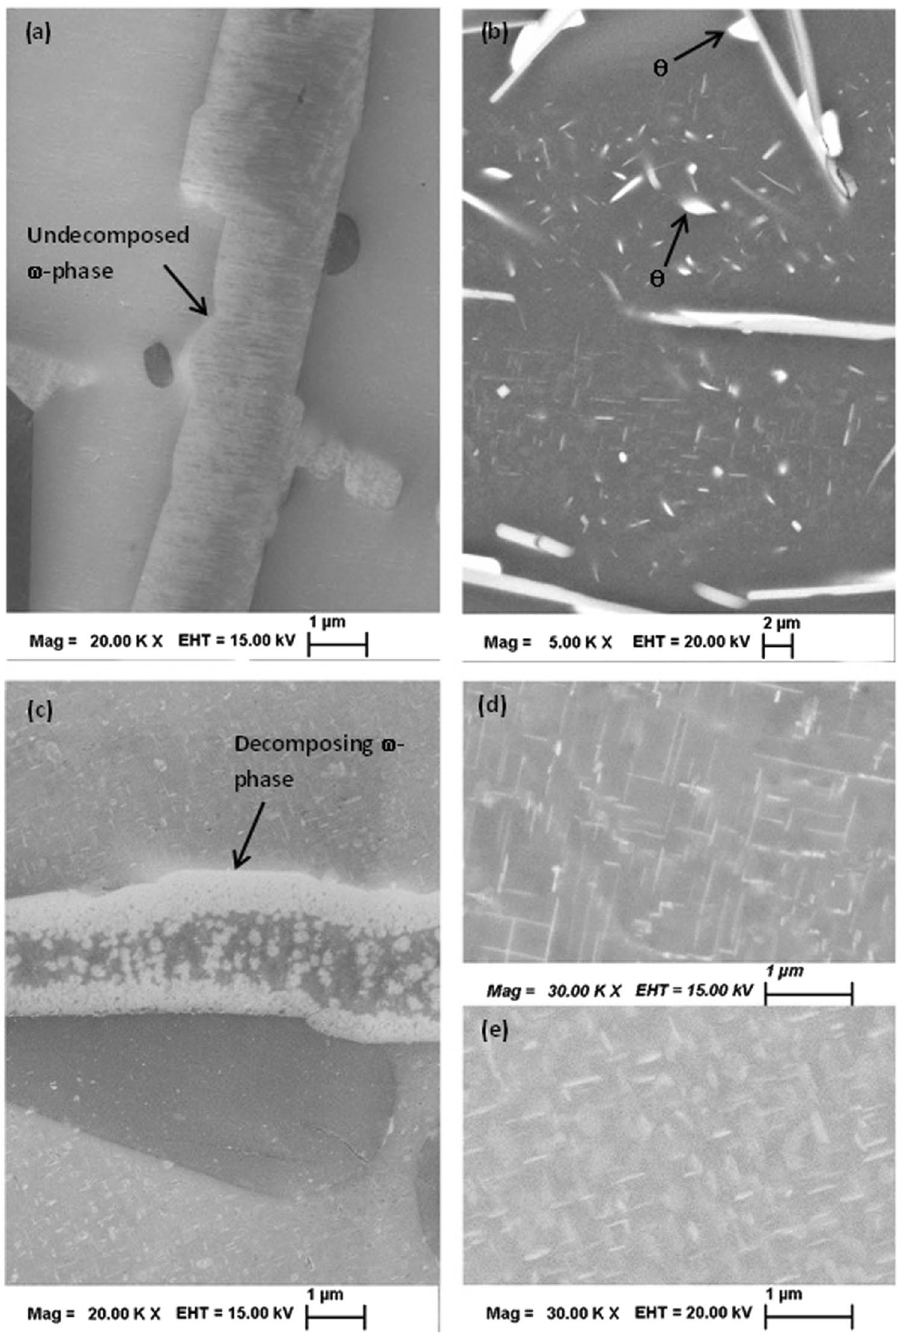
Figure 5. ( a ) In-lens SE image of 6Cu sample aged at 673 K for 432 ks showing undecomposed ω -phase (arrow); ( b ) BSE image of 4Cu sample aged at 573 K for 864 ks showing two types of θ -Al 2 Cu precipitates, in matrix and adjacent to the β -phase (marked by arrows) ( c ) In-lens SE image 6Cu sample aged at 473 K for 260 ks showing decomposing ω -phase (arrow). BSE image of 6Cu sample showing θ / precipitates in the matrix aged at 473 K for ( d ) 260 ks and ( e ) 950 ks. Number density of θ / precipitates is about 12/ μ m 2 and 10/ μ m 2 for ( d ) and ( e ),